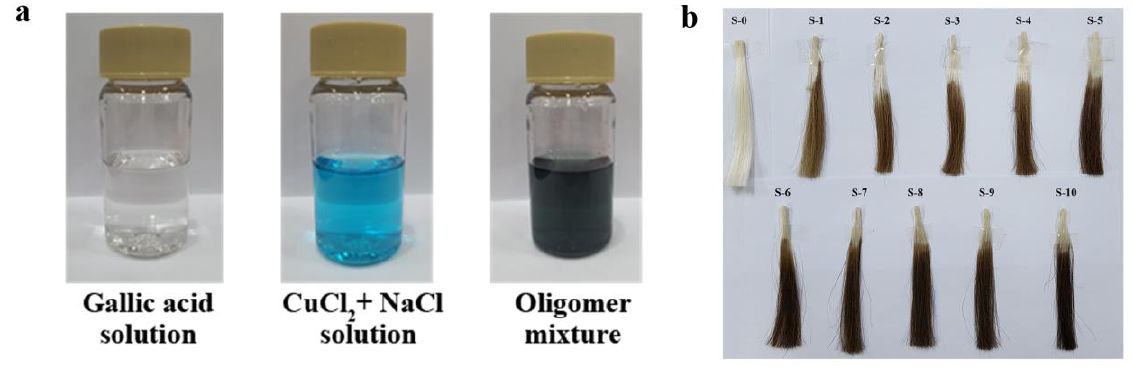
Figure 1. Photographs of ( a ) gallic acid, CuCl 2 + NaCl, oligomer-mixture solution mixture, and ( b ) the hair samples. ( b ) the hair